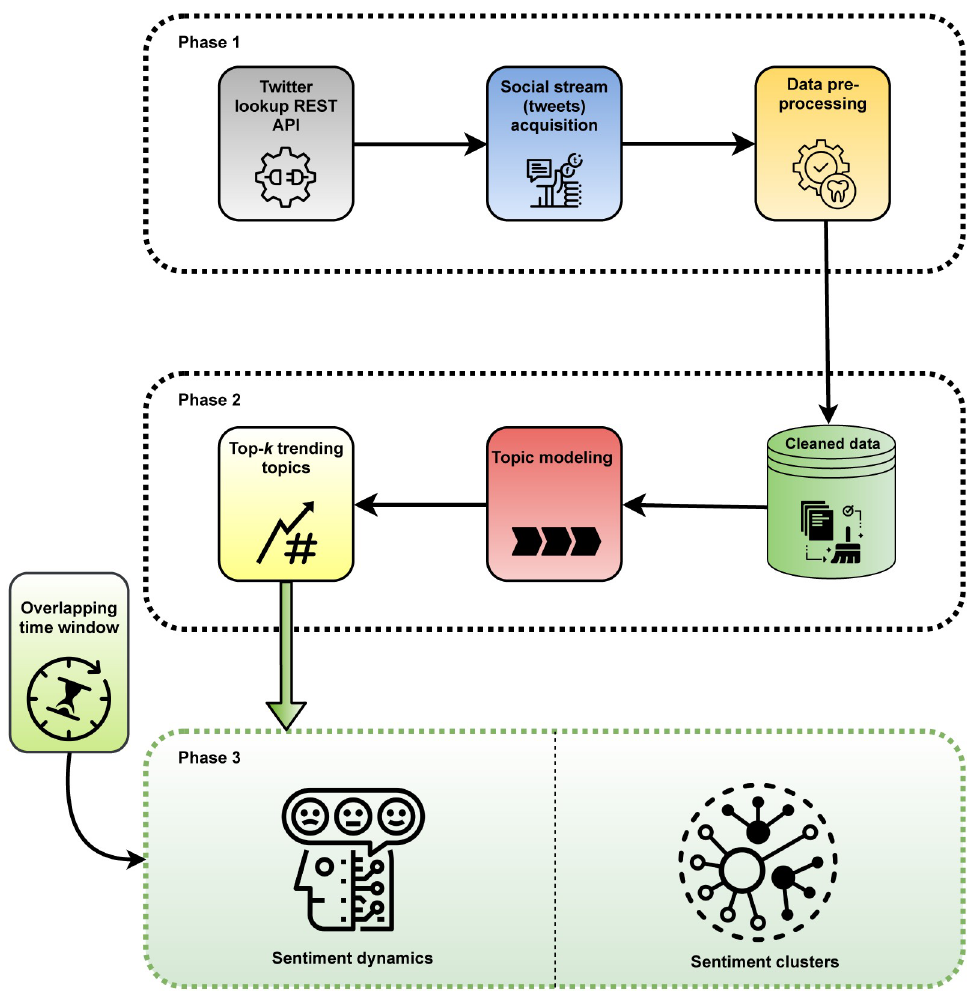
Fig 1. The workflow of the proposed framework (a methodical diagram representing the entire process from data collection to topic modeling and find out the sentiment dynamics and clusters).